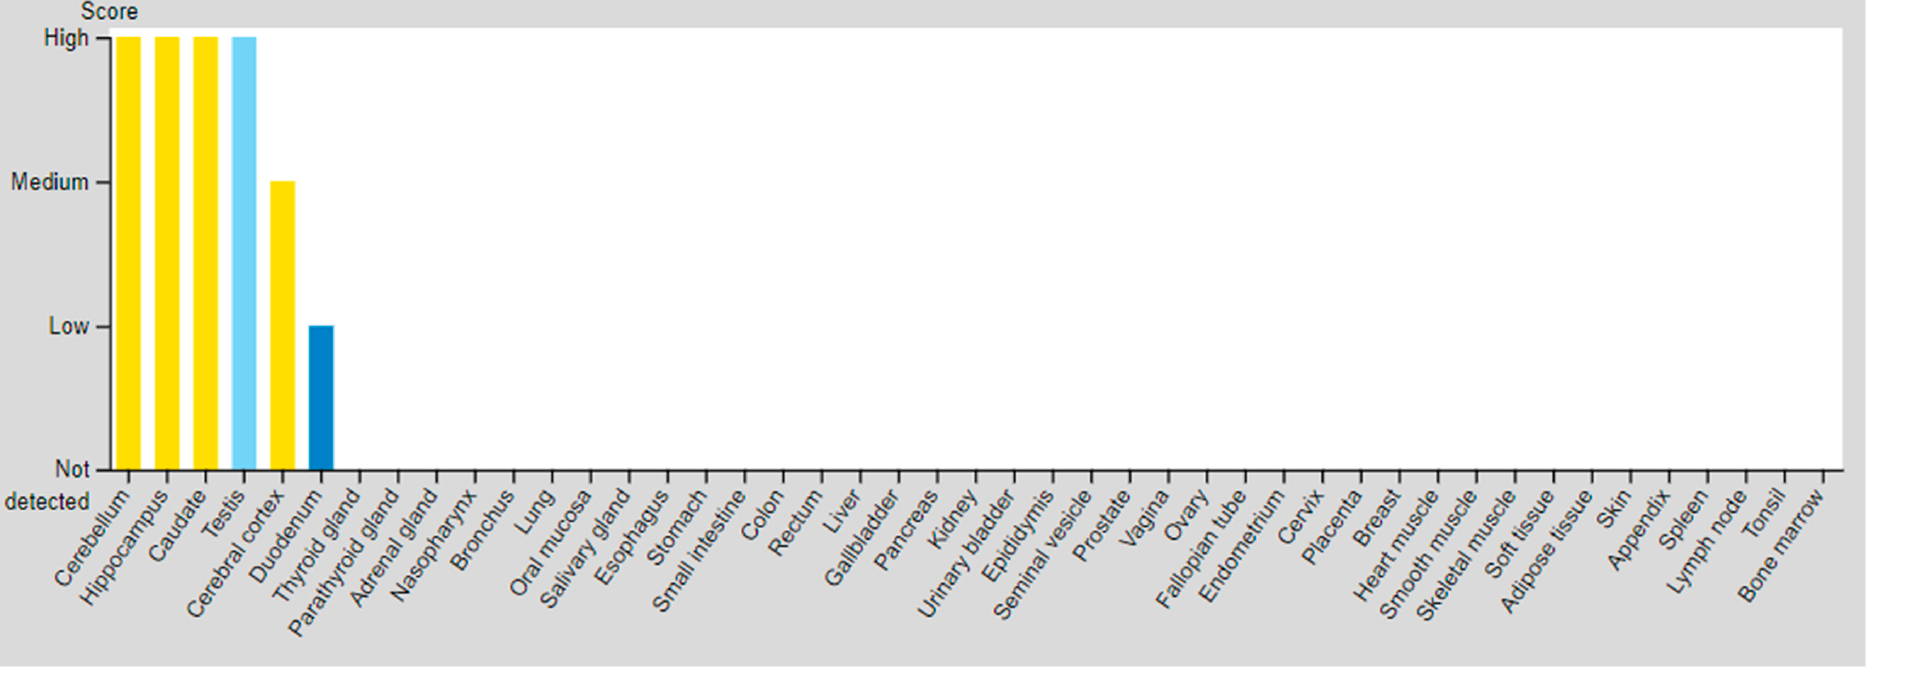
Figure 1. Comparison of SSTR2 ( top ) and SSTR3 ( bottom ) biodistribution based on expression rate of SSTR2,3 in mentioned tissues (From the Human Protein Atlas https://www.proteinatlas.org/ Accessed on 1 April 2022.).